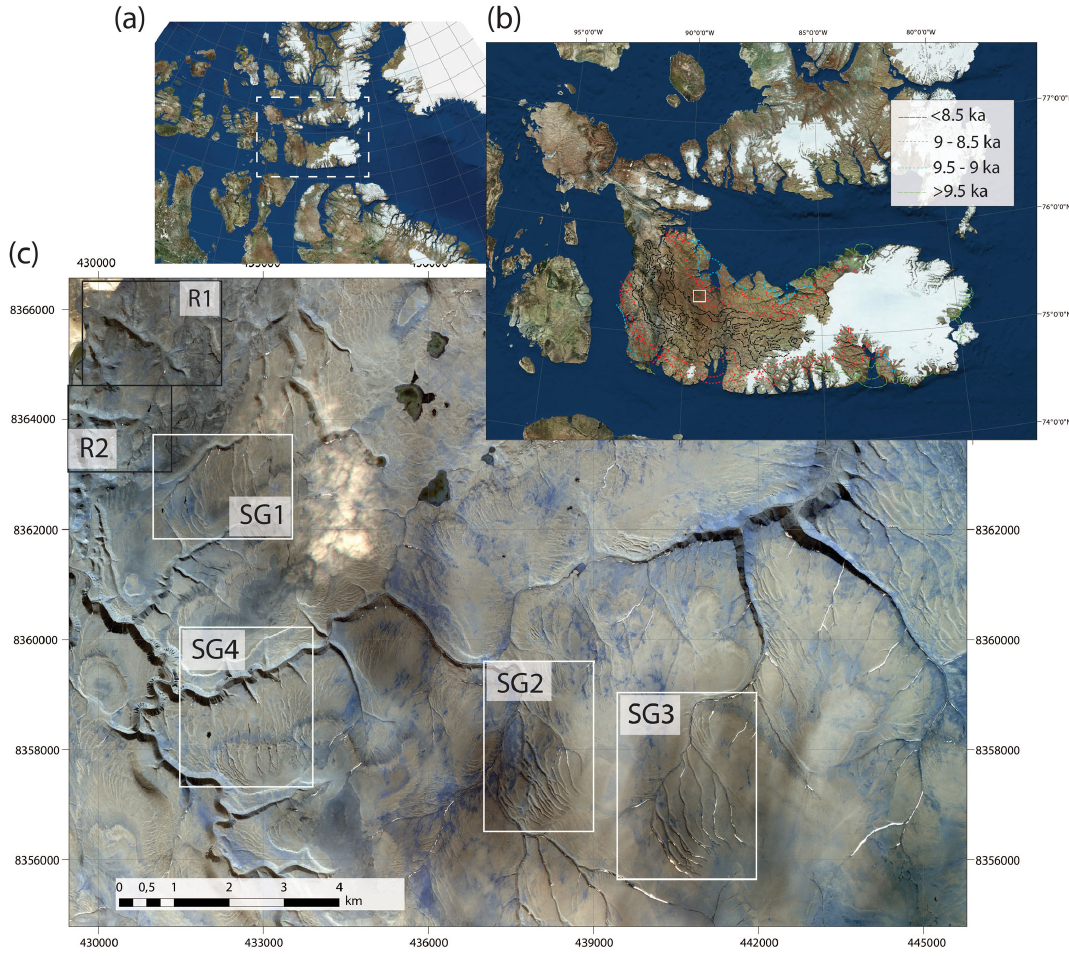
Figure 1. (a) Satellite imagery of Devon Island within the Arctic Archipelago (white box). (b) Satellite image of Devon Island, with a white box indicating the selected field site. The map also shows the Innuitian ice sheet terminus lines digitalized from Dyke (1999), with numbers referring to radiocarbon ages on glaciation in millennia before present (BP). (c) Field site (UTM zone 16), with boxes around each network investigated. White boxes are for subglacial networks (SG1, SG2, SG3, and SG4), whereas black boxes indicate fluvial networks (R1 and